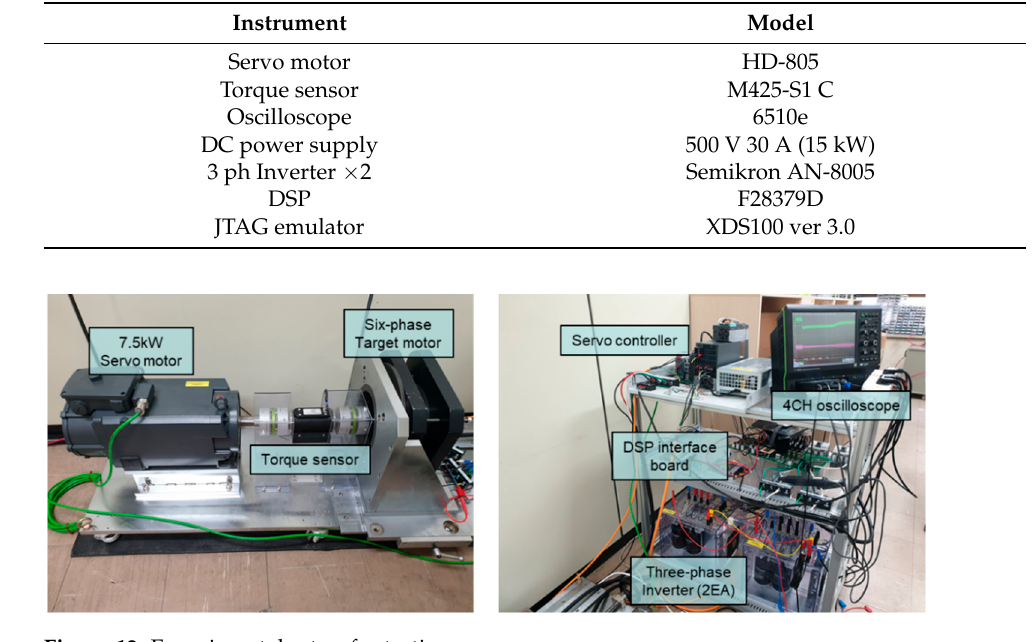
Figure 12. Experimental setup for testing.